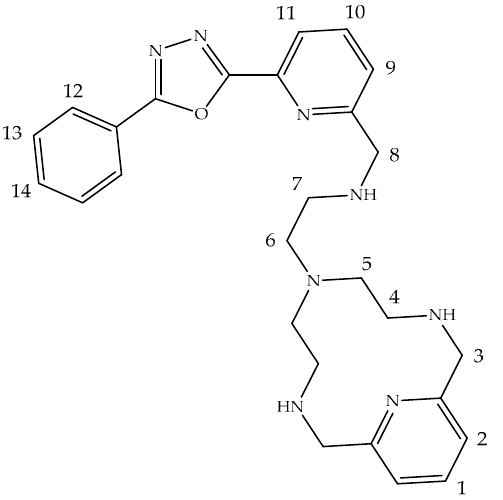
Figure 1. Structure of L with 1 H-NMR labeling scheme.